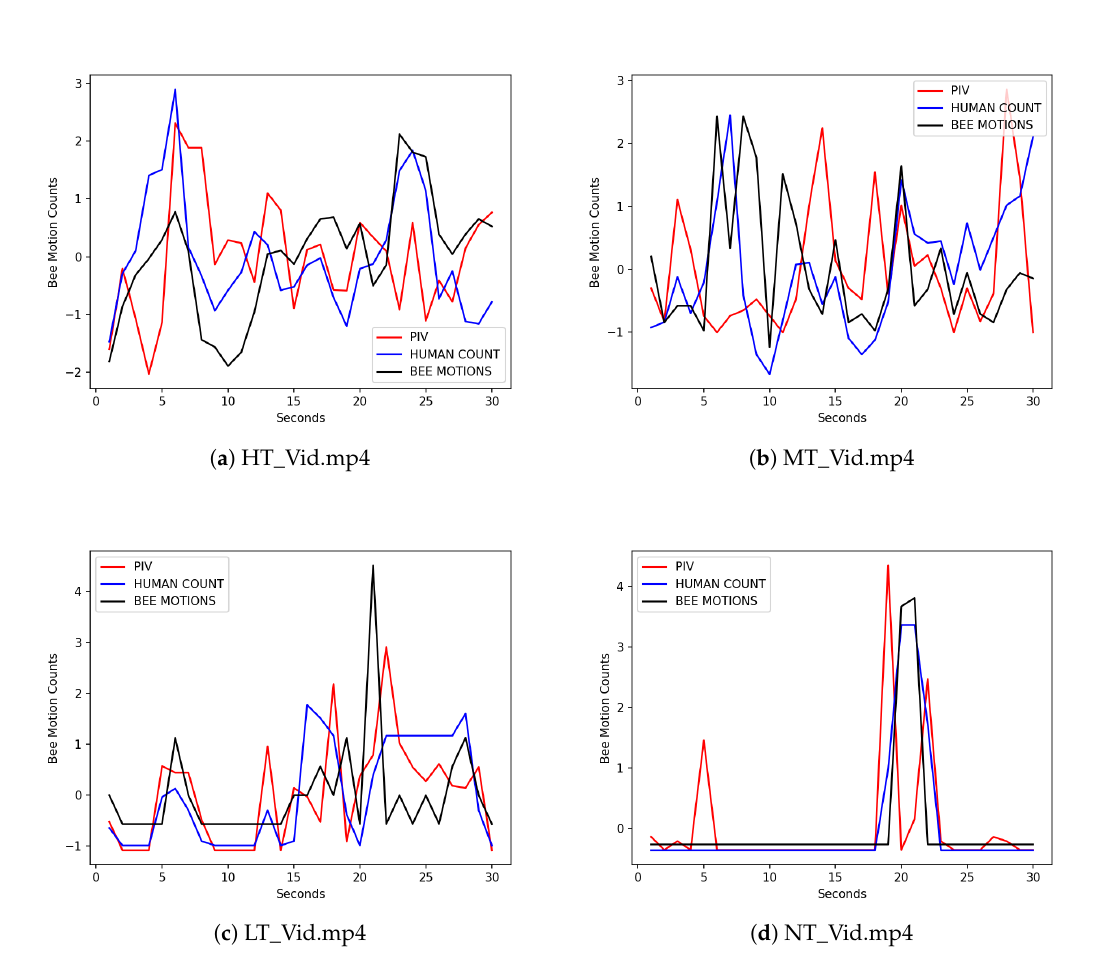
Figure 5. Plots of the three standardized variables on four evaluation videos, no traffic (NT_Vid.mp4), low traffic (LT_Vid.mp4), medium traffic (MT_Vid.mp4), and high traffic (HT_Vid.mp4). The total number of frames examined were 216,956 video frames. The x-axis is the time (in seconds) when each video frame is captured. The y-axis is the values of the standardized variables C ∗ (DPIV), C ∗ 2 1 (MOG2/VGG16), and C ∗ (Human Count). C ∗ is the ground truth. Let F t and F t + 1 be two consecutive 3 3 ( t + 1 ) is the standardized value of T ( F t , F ) , frames captured at times t and t + 1, 1 ≤ t ≤ 29. C ∗ t + 1 f 1 ( t ) is the standardized value of the count returned by the MOG2/VGG16 algorithm for F t , and C ∗ C ∗ is 2 3 ( 1 ) = C ∗ ( 1 ) = C ∗ ( 1 ) = the standardized value of the count returned by the human counter for F t . C ∗ 2 3 1